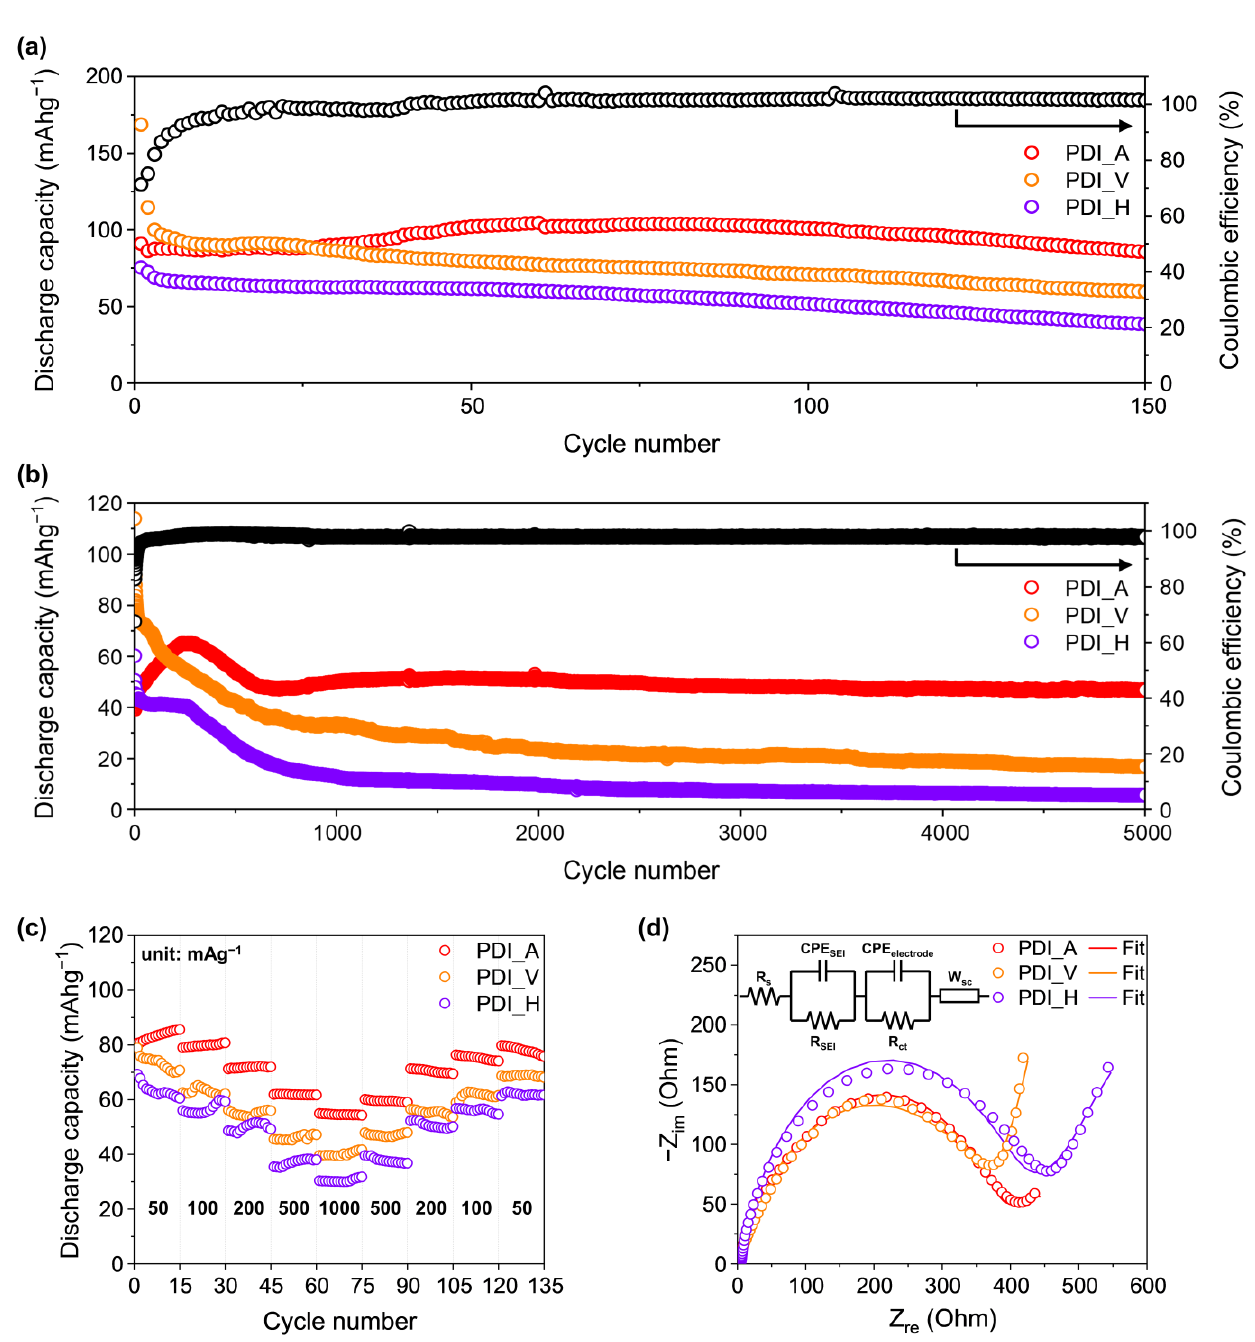
Figure 3. Galvanostatic charge – discharge cycle performance of PDI_AAs cathodes at ( a ) 50 mAg −1 and ( b ) 500 mAg −1 (black circle: PDI_A’s coulombic efficiency) ; ( c ) rate capability at different current densities; ( d ) Nyquist plot of PDI_AAs cathodes.